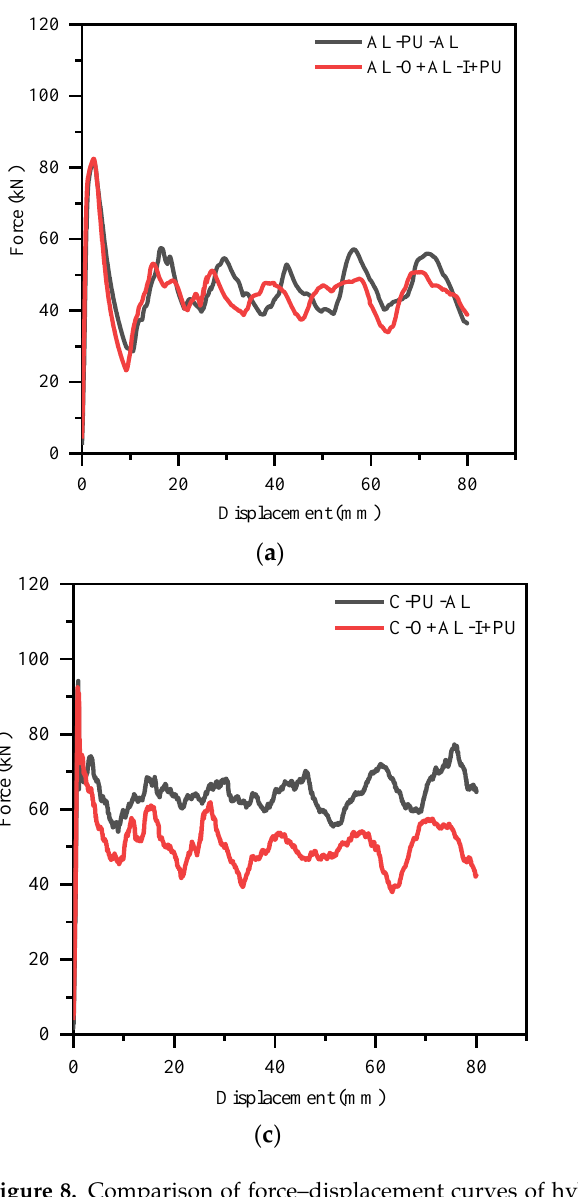
Figure 8. Comparison of force–displacement curves of hybrid structures and sum of their individual components: ( a ) AL-PU-AL; ( b ) AL-PU-C; ( c ) C-PU-AL; ( d ) C-PU-C.